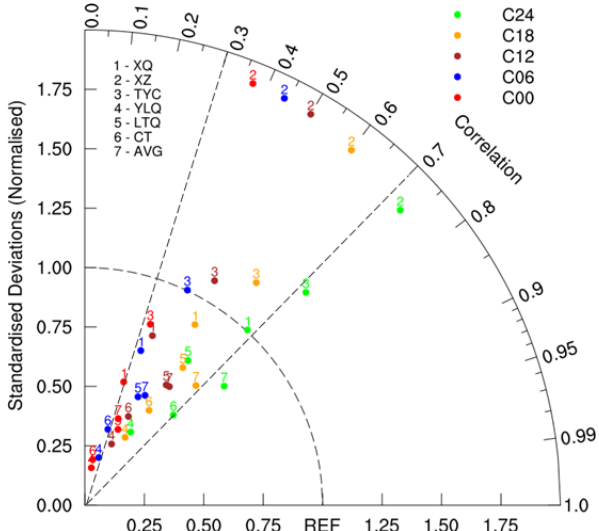
Figure 8. Taylor nomogram for modelled and observed daily av- eraged PM 2 . 5 concentrations for the sensitivity experiment using the clean initial condition files. “AVG” refers to the average of 13 NSAQ stations. The C00, C06, C12, C18, and C24 sensitivity exper- iments are represented using different coloured symbols. According to Chang and Hanna (2004), REF represents a perfect simulated re- sult for the air quality model.